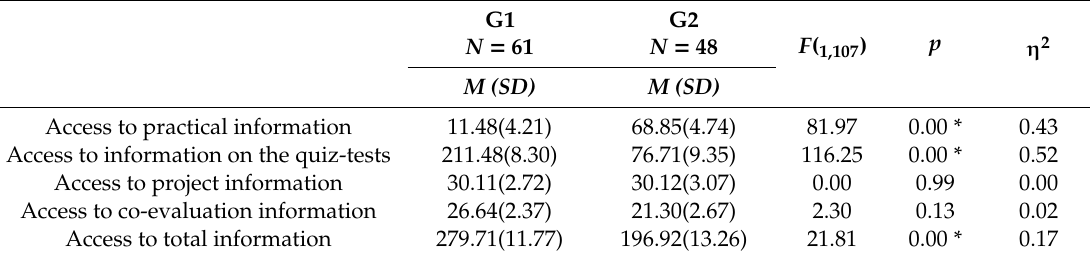
Table 2. A single factor fixed-e ff ects ANOVA (IPA use vs. non-use).